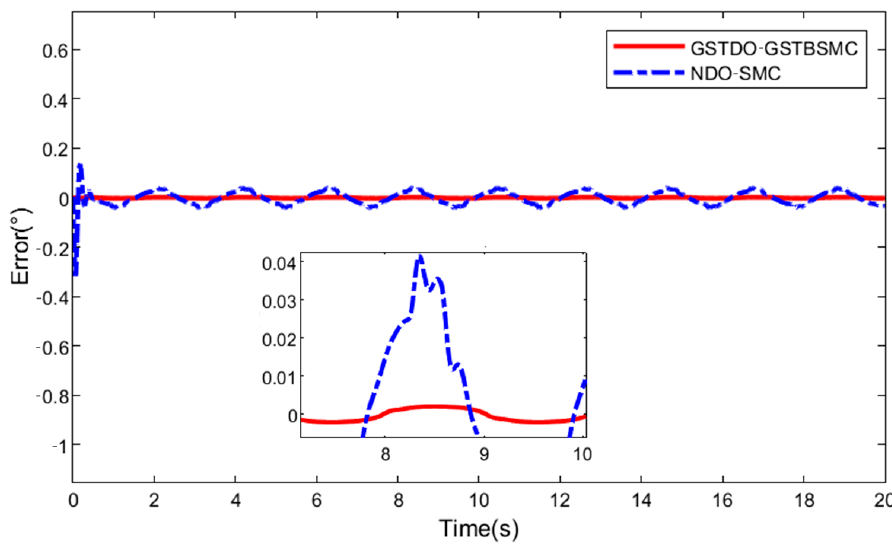
Figure 16. Comparison of the tracking error between GSTDO-GSTBSMC and NDO-SMC in Exper- iment 3.